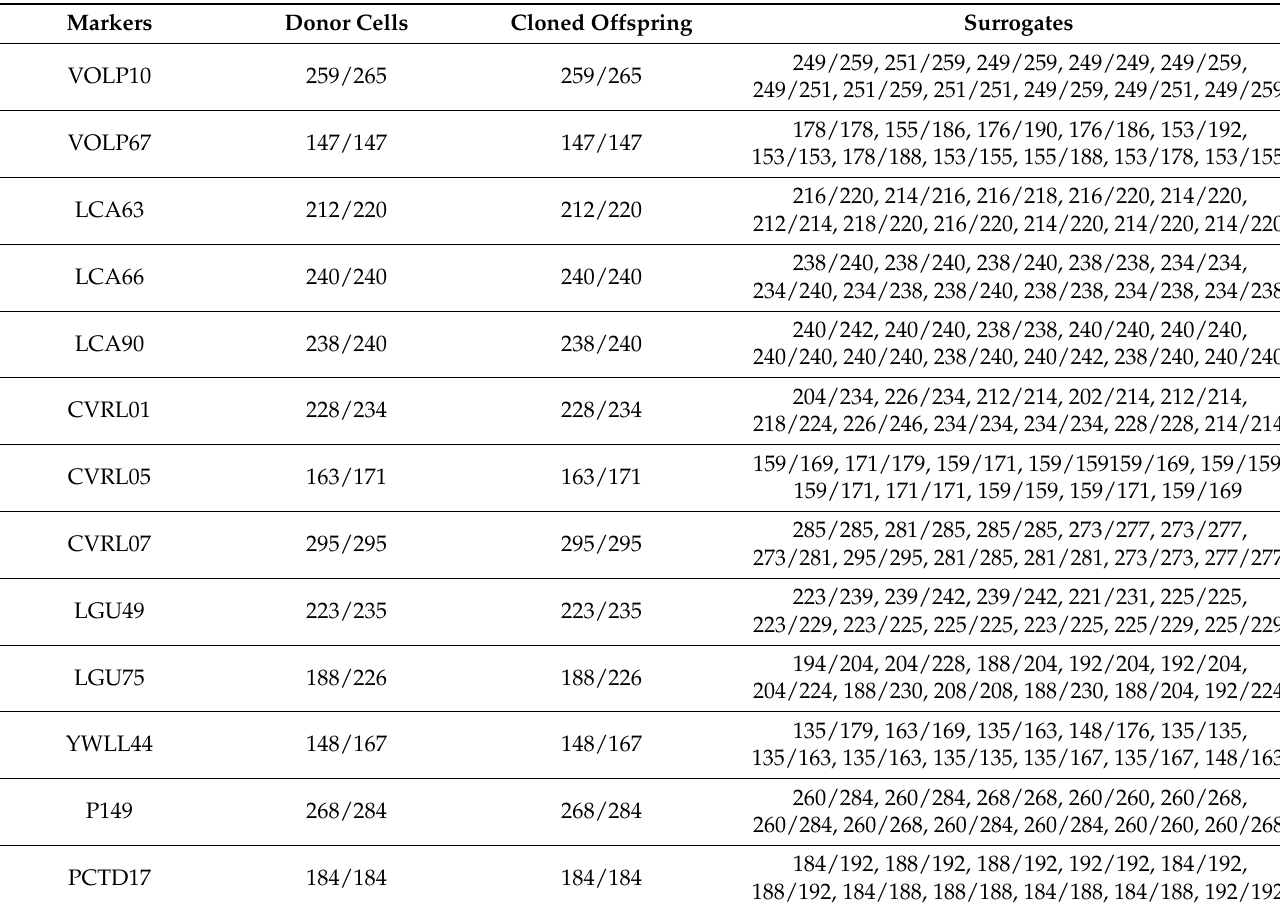
Microsatellite analysis was performed on genomic DNA from cloned offspring, surrogate, and donor cells. The values of all markers were confirmed identically in all cloned offspring. Values represent the base pairs of the amplified microsat- ellite DNA markers in each sample.